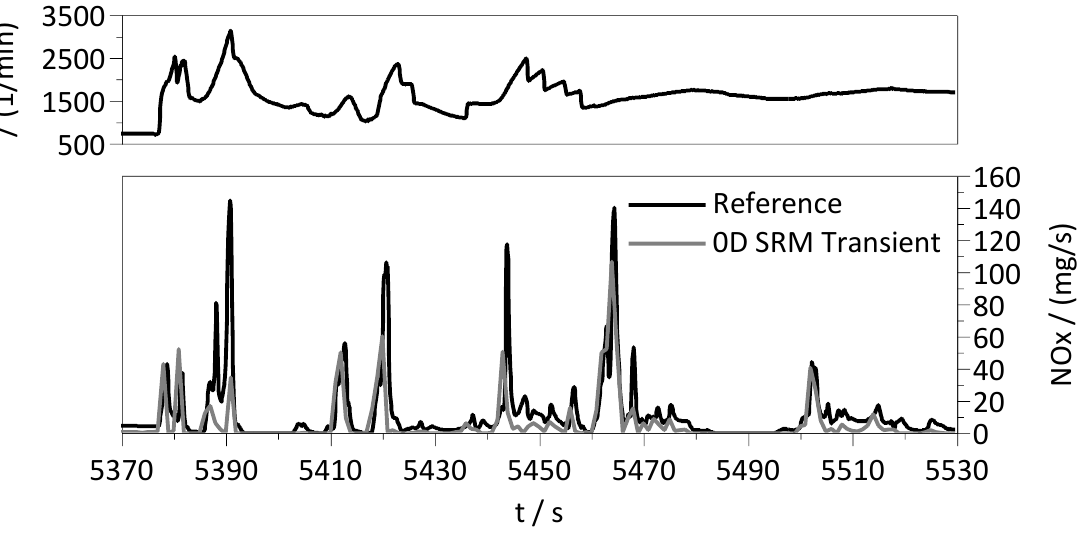
Figure 13. Detail of the NOx mass flows between the simulation and reference measurements of the motorway section of an RDE test cycle.